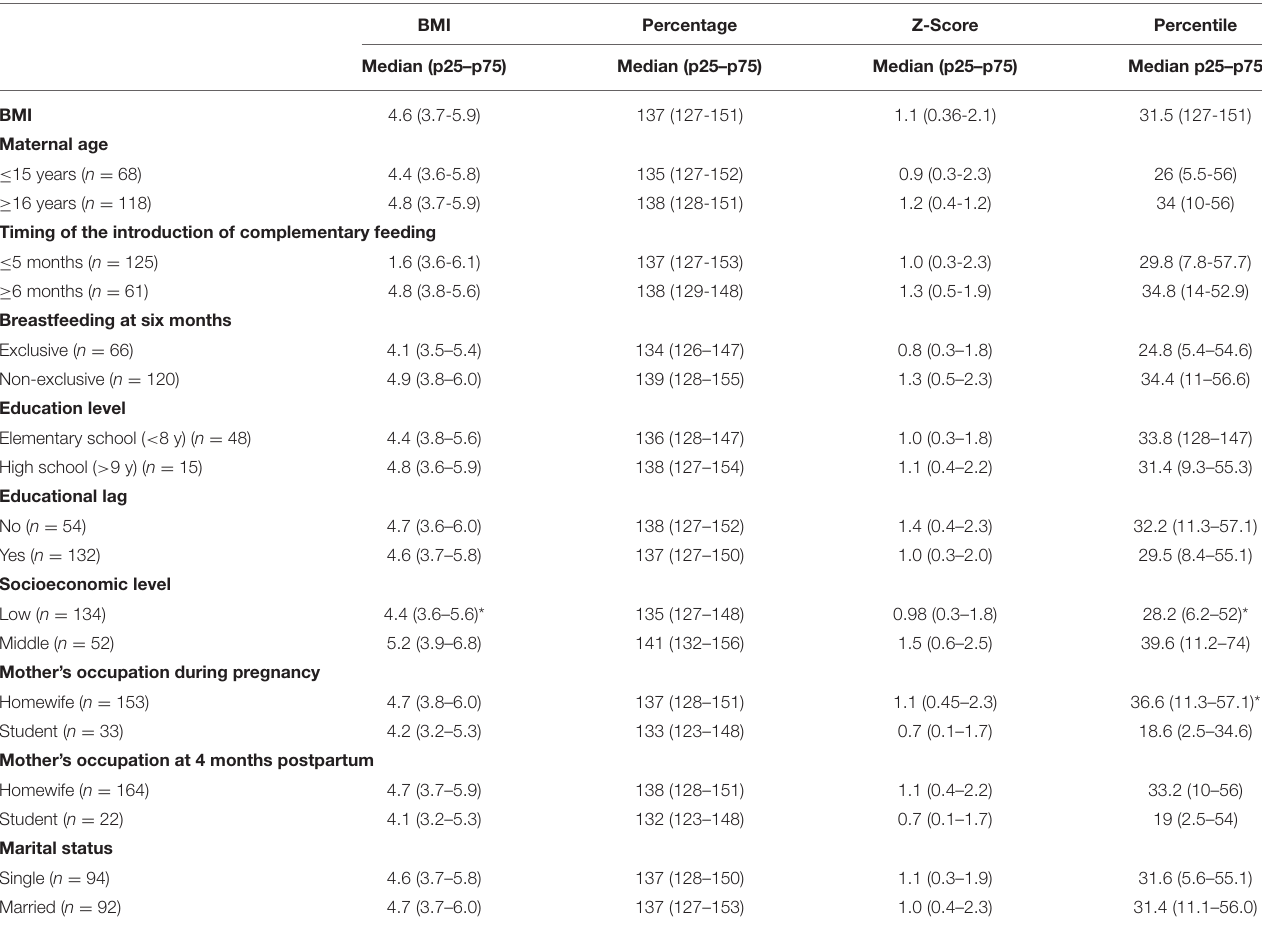
TABLE 4 | Change of BMI (delta) according to maternal sociodemographic